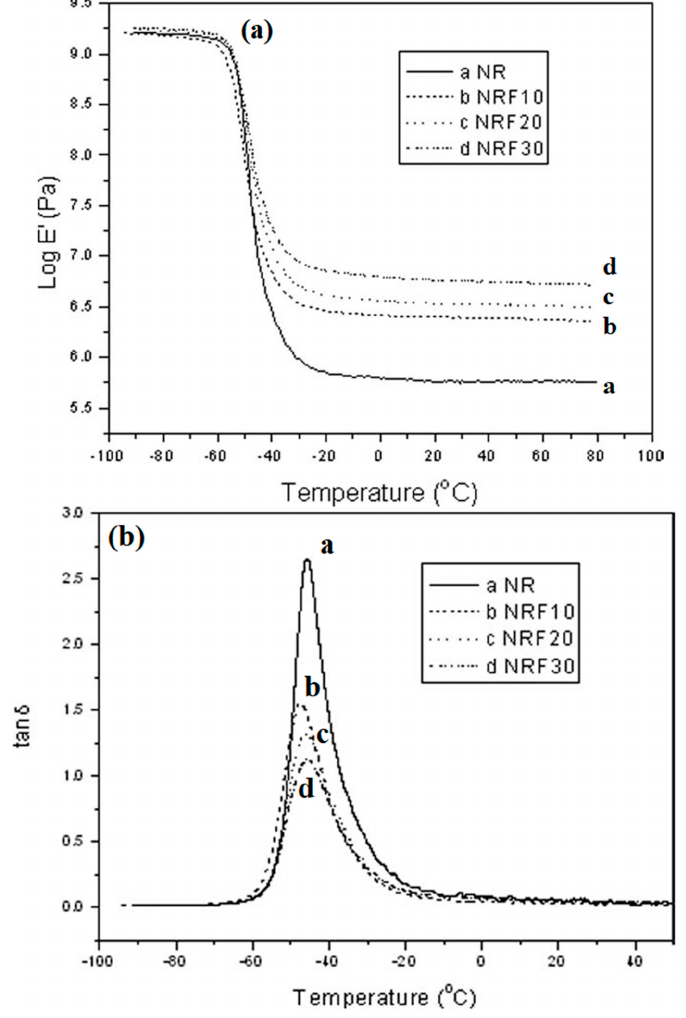
Figure 3. ( a ) Storage modulus and ( b ) loss factor (tan δ ) as a function of temperature for NR composites filled with different contents of untreated oil palm fiber. NRFx denotes oil palm/NR composites, where x is the filler content in phr (adapted with permission from [49]).